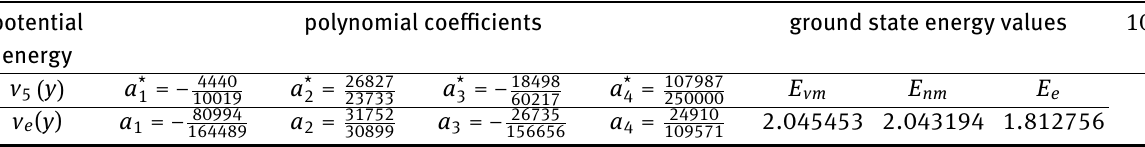
polynomial coeflcients